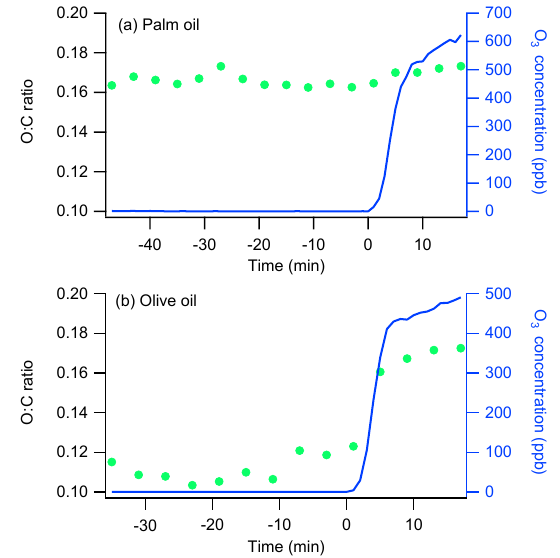
Figure 2. Time series of O:C ratios and O 3 concentrations for oxidation flow reactor ozonolysis experiments with (a) palm and (b) olive oil. The ozonolysis experiments involved exposing emis- sions from palm or olive oil to high concentrations of O 3 in an oxi- dation flow reactor. The emissions first passed continuously through the reactor for at least 30min and then were exposed to 500–600 ppb ozone for another 17min. Ozone was introduced at time t = 0.